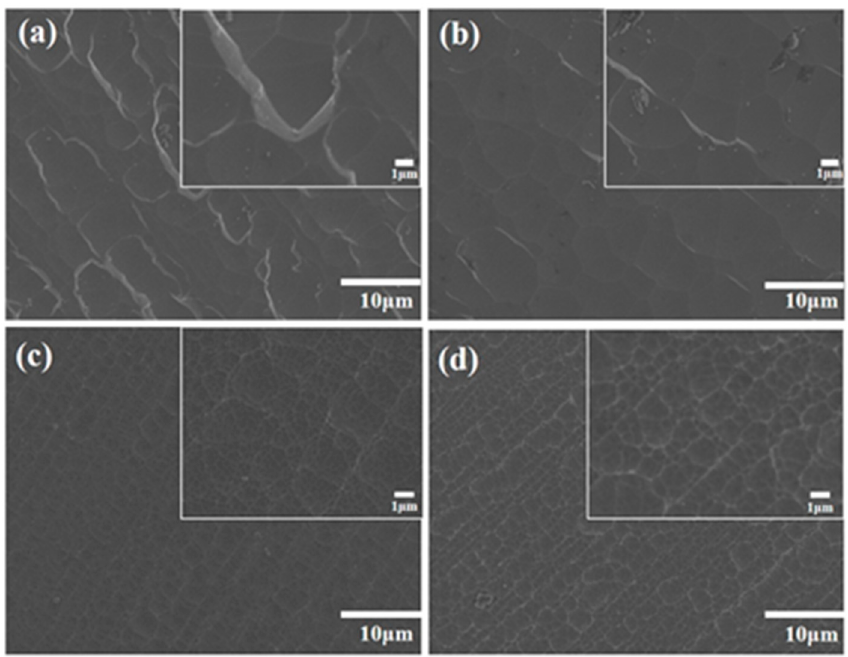
Figure 4. SEM images of the Si surface etched in 0.175 M NH 4 HF 2 Ag@PVP–ACE solution with different H 2 O 2 concentration: ( a ) 0.3 M; ( b ) 0.6 M; ( c ) 1.2 M; ( d ) 1.5 M. All above samples were etched at 65 °C for 20 min.